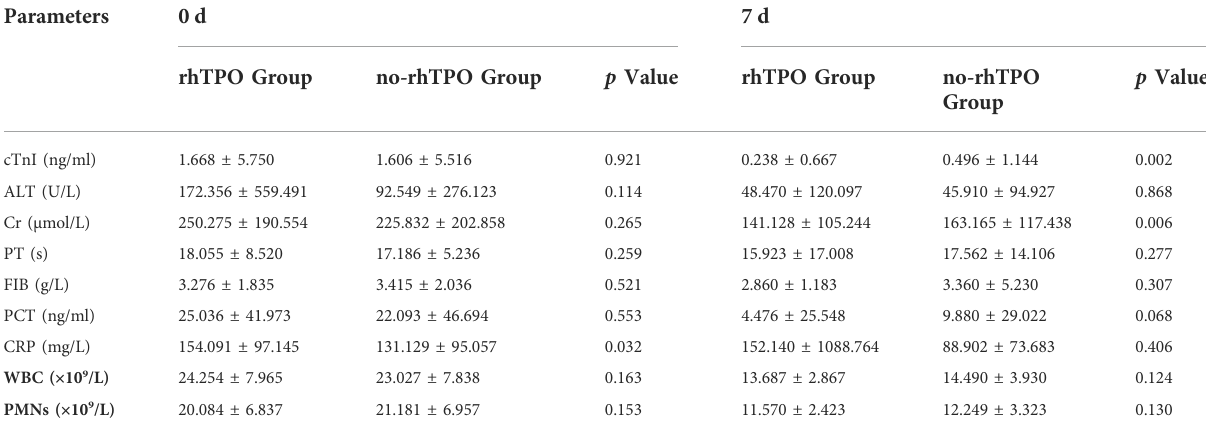
For all patients, the proportion of transfusion of red blood cells, platelets, and plasma was 61.77, 50.15 and 41.59%, respectively. Compared to the no-rhTPO group, the rhTPO